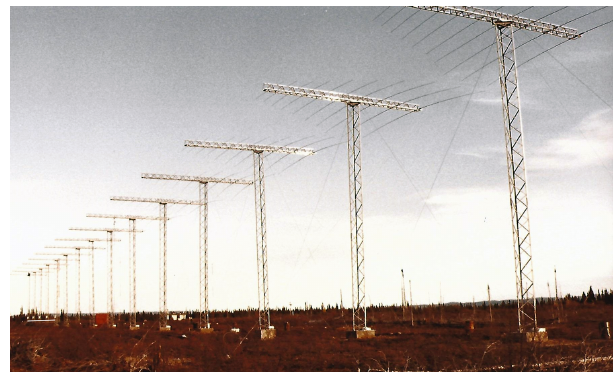
Figure 1. View of the Goose Bay HF antenna array after the towers and antennas were installed. The power radiated by the antennas is directed toward the left in this figure. Note the red equipment shed at the center of the array. It contains power supplies for the trans- mitters, the phasing matrix, and digital switches for controlling the pointing direction of the selected beam. To the right of the phasing shed is a white building that is located 350m beyond the center of the array. This building contains the computers for controlling the radar and processing and displaying the acquired data. At the far end of the array, one can see that five of the transmitters have been mounted on the towers. The remainder are sitting on the concrete bases for the